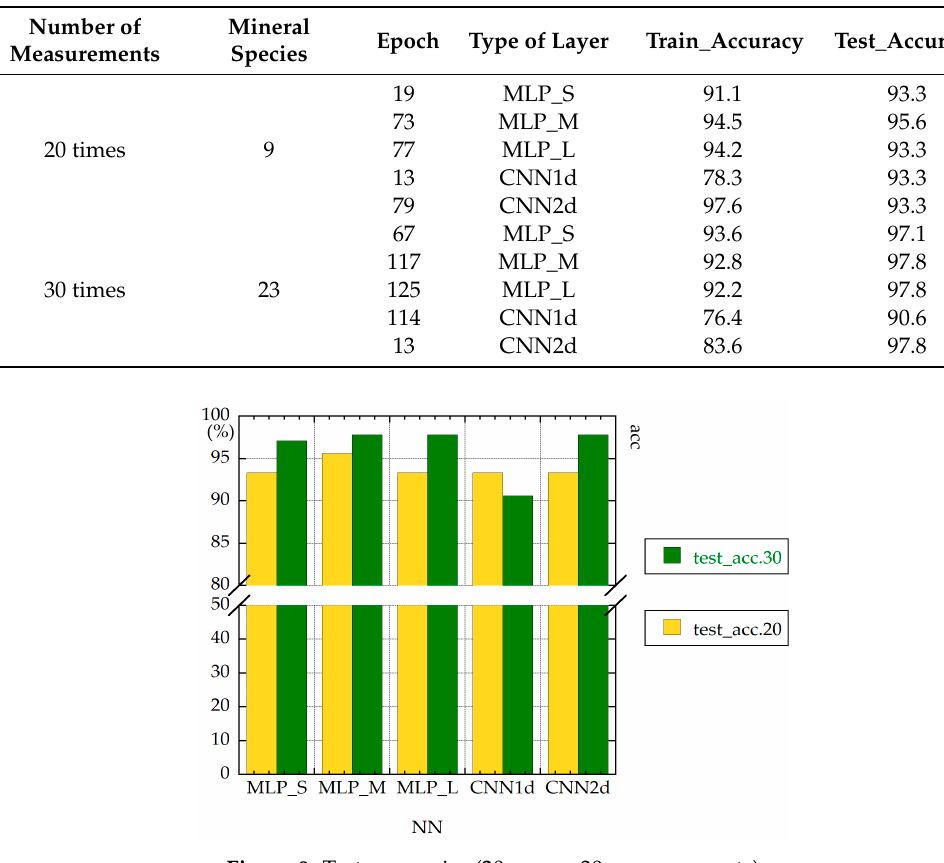
Figure 9. Test accuracies (20 versus 30 measurements). Table 6. Results of K-fold cross-validation without HQ.